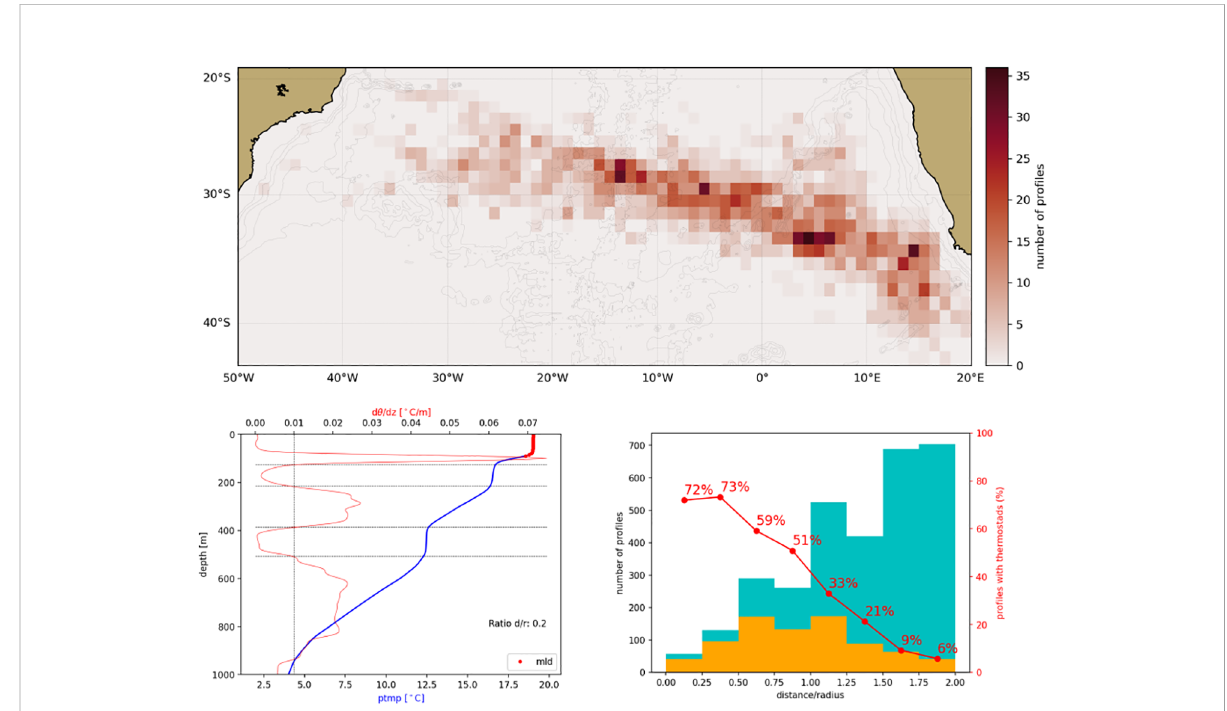
FIGURE 2 Temperature pro fi les inside Agulhas rings along the South Atlantic between 1993 and 2016. Top) Distribution of coincident temperature pro fi les and Agulhas rings, totaling 3,076 pro fi les, in a 1° x 1° resolution grid. The bottom topography is shown in the background in faded gray lines. Left) Temperature pro fi le acquired within an Agulhas ring on the geographic coordinates 27.92°S of latitude and longitude 20.22°W, on 27-Jul- 2006, close to the ring center (ratio distance/radius = 0.2). The red line indicates the vertical temperature gradient, and the red dots mark the mixed layer. The vertical dashed line marks the threshold for the vertical temperature gradient at 0.01°C/m. Right) The number of pro fi les acquired within Agulhas rings versus the ratio between the distance from the ring center and ring radius. Cyan: all the pro fi les; Orange: pro fi les with mode water signal. Red line: the percentage of pro fi les with detected thermostad in each class interval of